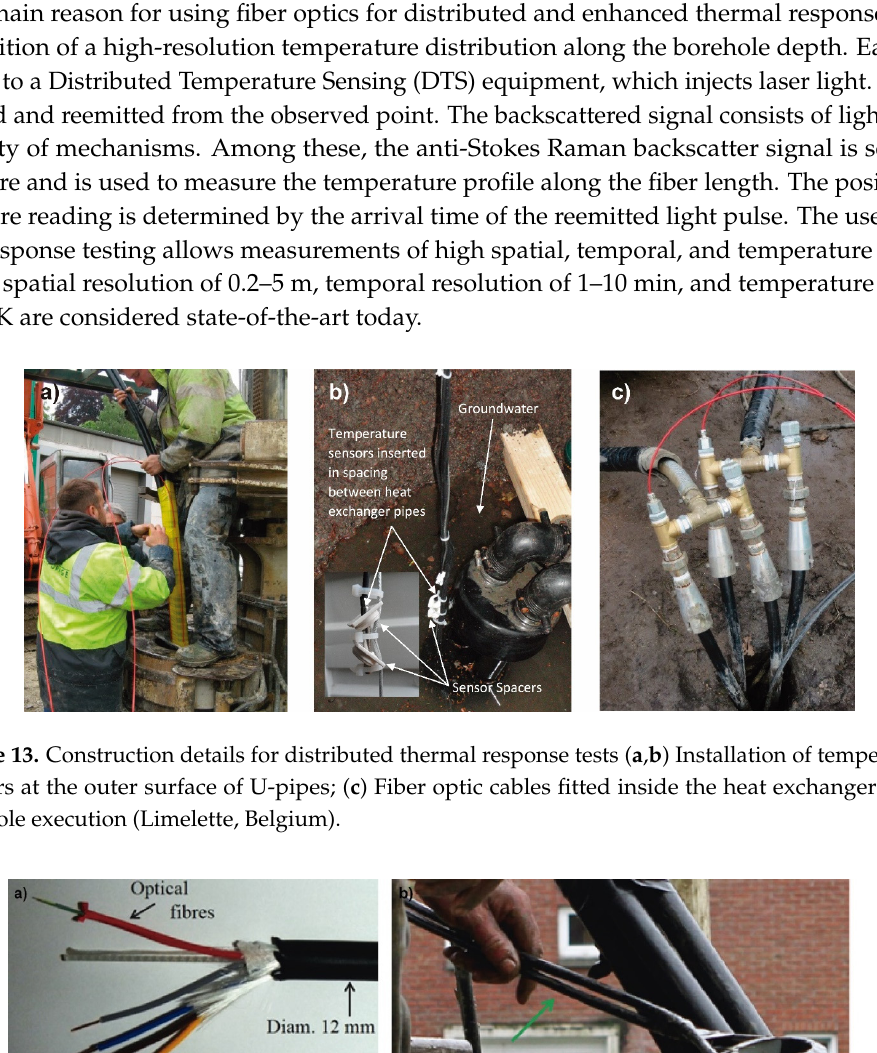
Figure 14. Hybrid cables for enhanced thermal response testing ( a ) Picture of a hybrid cable with indication of all different components; ( b ) U-loop of the hybrid cable, to be attached to the bottom of the borehole heat exchanger before their installation in the borehole.